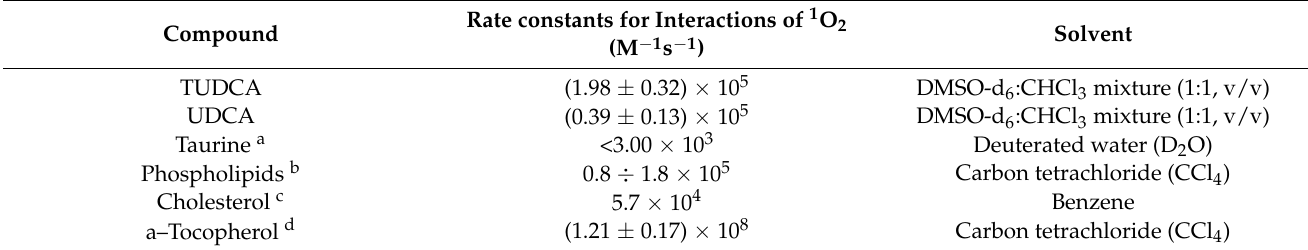
Table 1. Summarized bimolecular rate constants of interaction of TUDCA and UDCA with singlet oxygen calculated from straight-line slopes presented in Figure 2B. Rate constant of 1 O 2 ( 1 Δ g ) quenching by taurine from Egorov et al. [64].